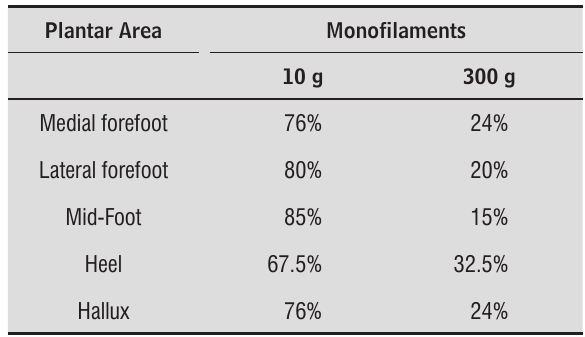
Table 3 - Distribution in percentages of the stimulus dis- crimination of monofilaments in plantar areas in relation to the number of individuals (n = 17)